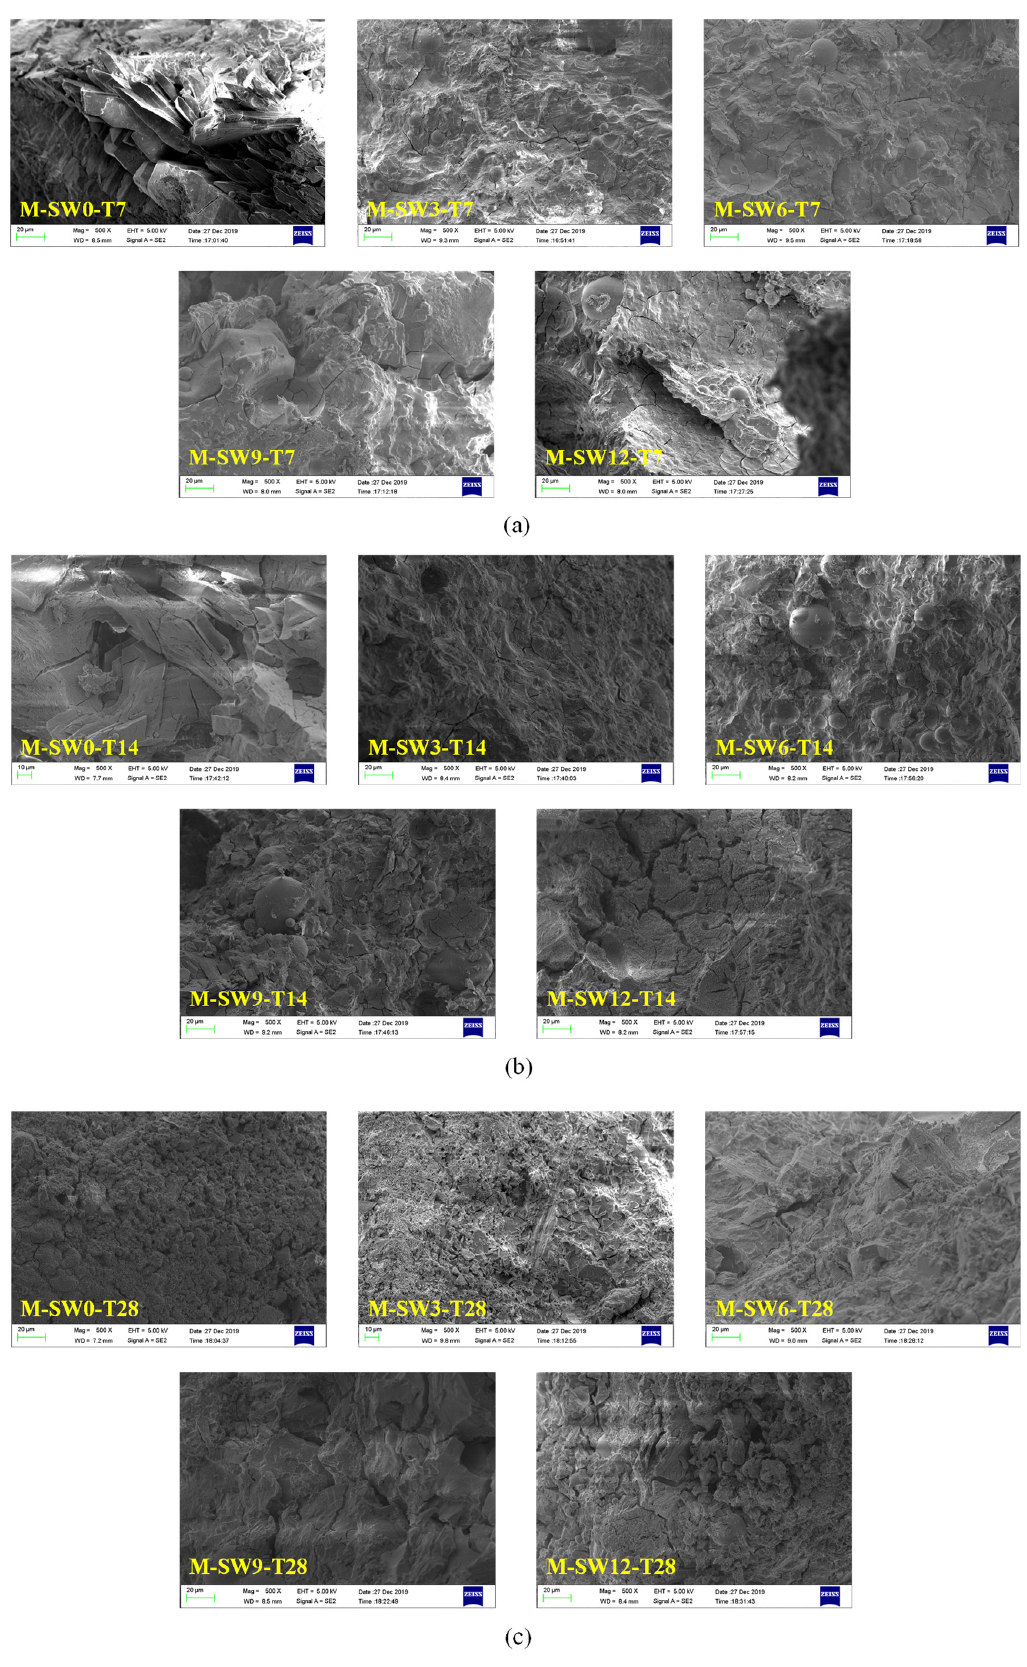
Figure 11. Scanning electron microscope ( SEM) analysis of specimens. ( a ) T7; ( b ) T14; ( c ) T28.